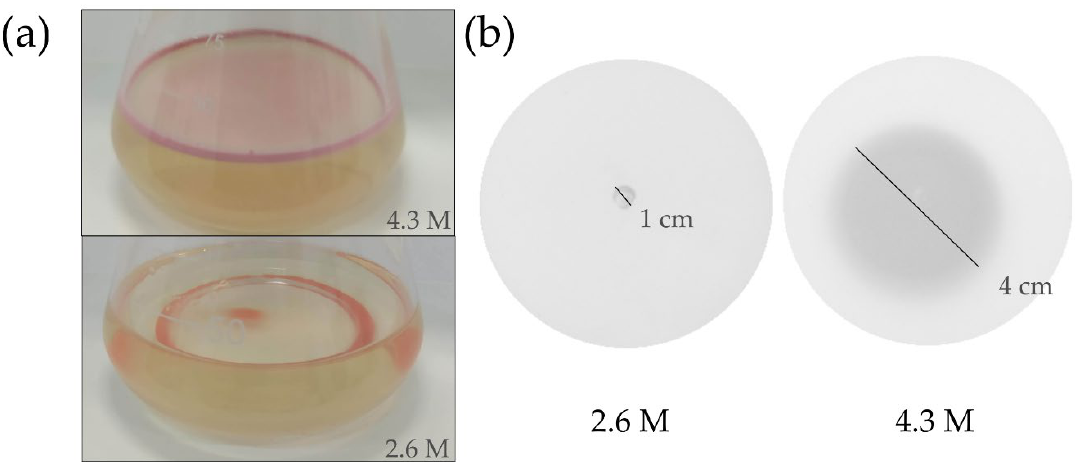
Figure 1. Buoyancy and motility phenotypes were observed in salt-stressed cultures. The optimum growth condition is 4.3 M NaCl and low salt is 2.6 M NaCl. ( a ) Fluctuation of cells in optimal salinity and sinking of cells in hyposalinity. ( b ) A motility assay showed less motility of cells in hyposalinity.